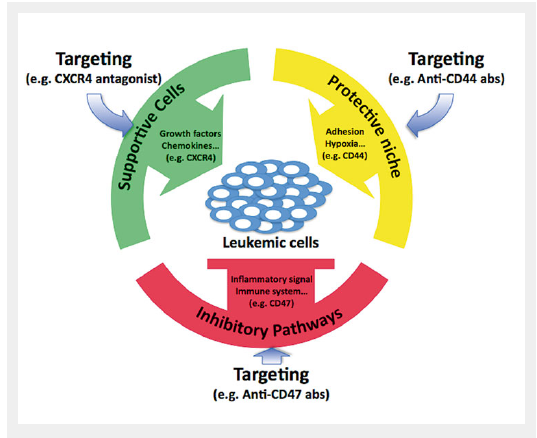
Potential therapeutic targeting of interactions of leukaemic cells with the micro-environment. In the bone marrow, leukaemic cells can take advantage of the protective and supportive feature of the microenvironment, and may also impair inflammatory signal and immune response. Targeting the interactions with the microenvironment may repress the benefit from the niche and restore the endogenous inhibitory pathways to control the leukaemic cell